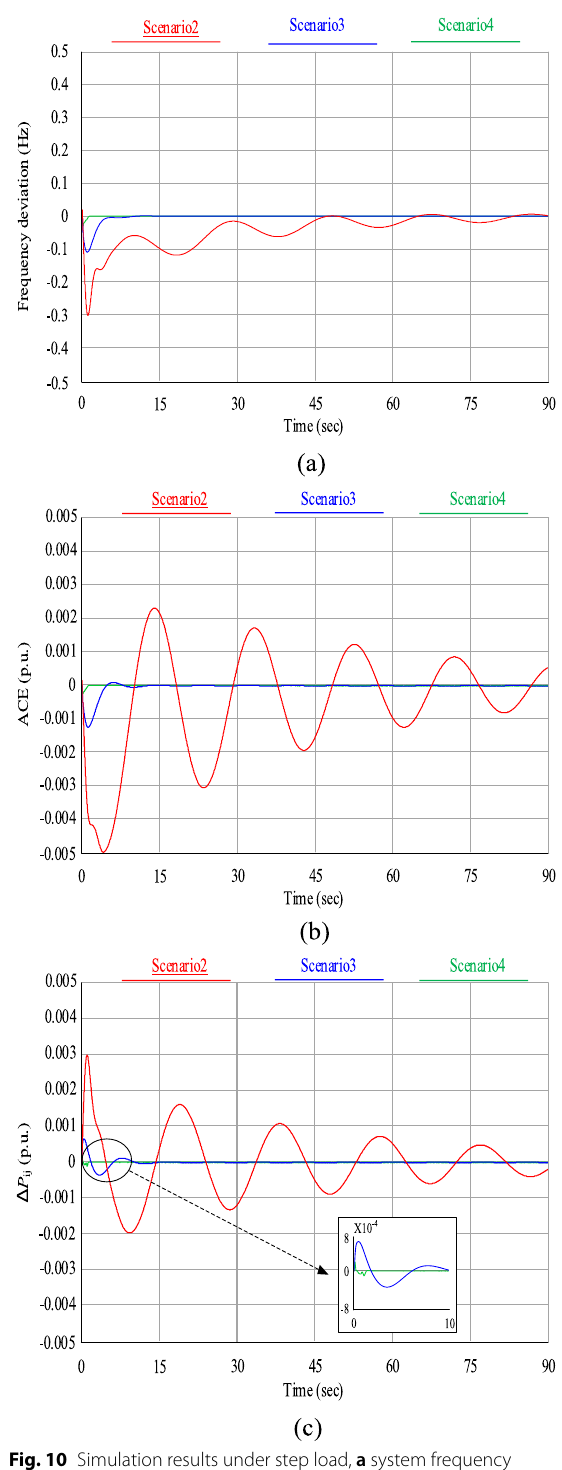
Fig. 10 Simulation results under step load, a system frequency deviation, b ACE deviation of area one, c power deviation of